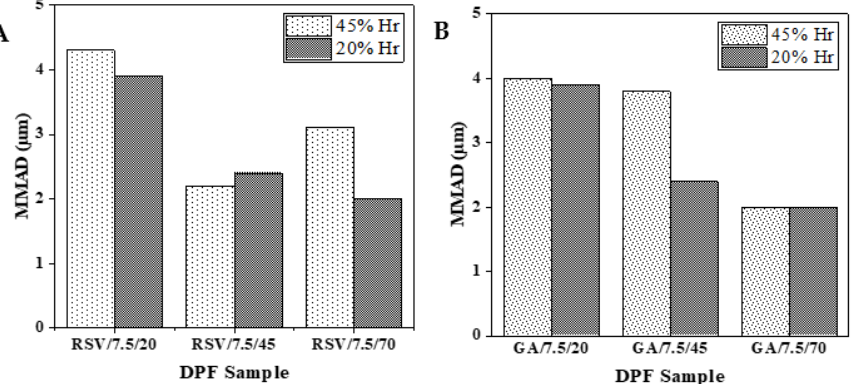
Figure 10. Mass median aerodynamic diameter (MMAD) for 7.5 % w / v DPFs stored at different %RH, varying ethanol from 20 to 70 % v / v : ( A ) RSV – DPFs ( B ) GA – DPFs.